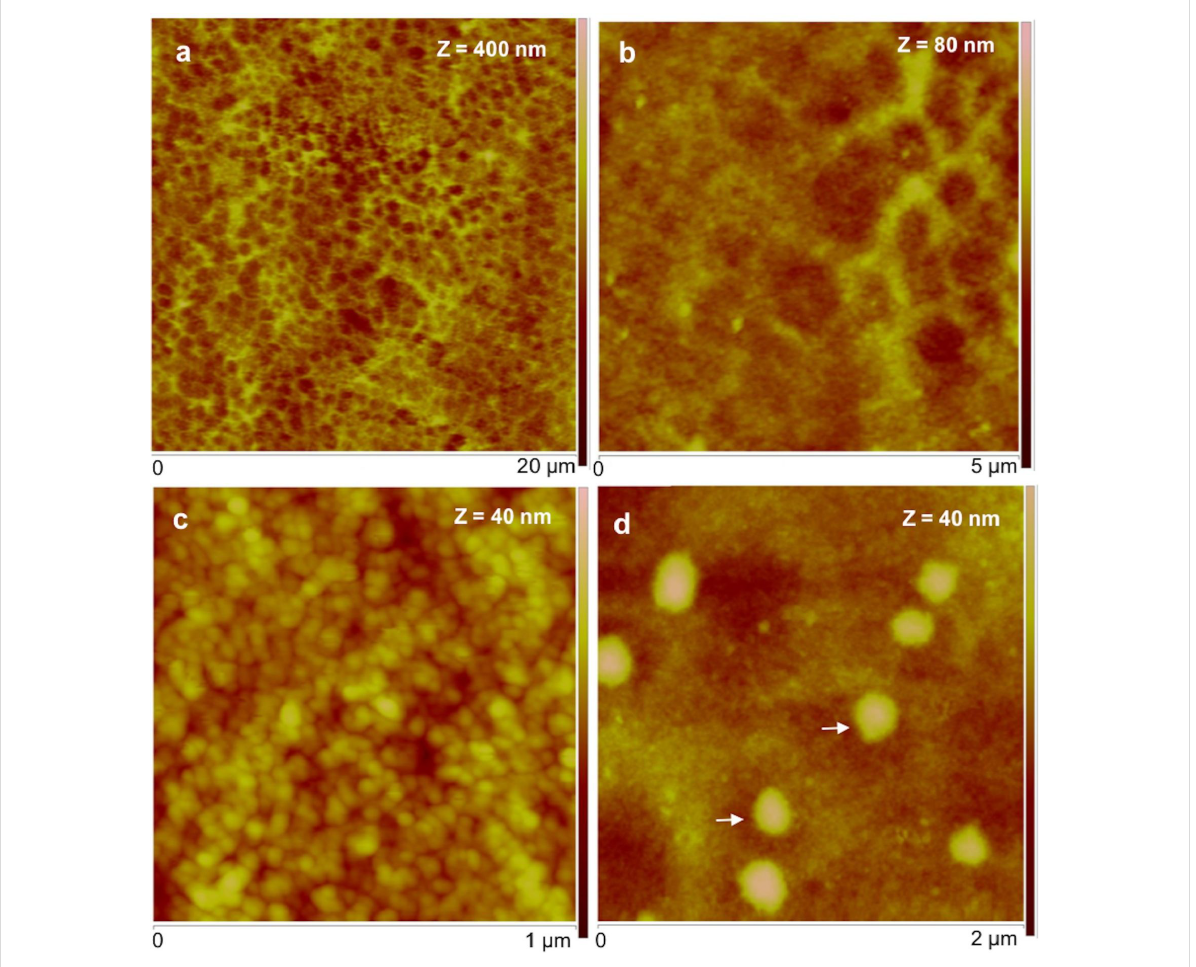
Figure 3: Peak force tapping AFM (PFT-AFM) images of moist adhesive material deposited by the tube feet of Paracentrotus lividus on mica. a) Height image observed in air. b) Higher resolution of the same area showing the honeycomb appearance of the meshwork. c) Detailed topography view showing that the meshwork is composed of aggregated globular nanostructures. d) Detailed topography view of a different area showing bigger globular structures denoted by white arrows. Images were obtained with a ScanAsyst-Air probe.